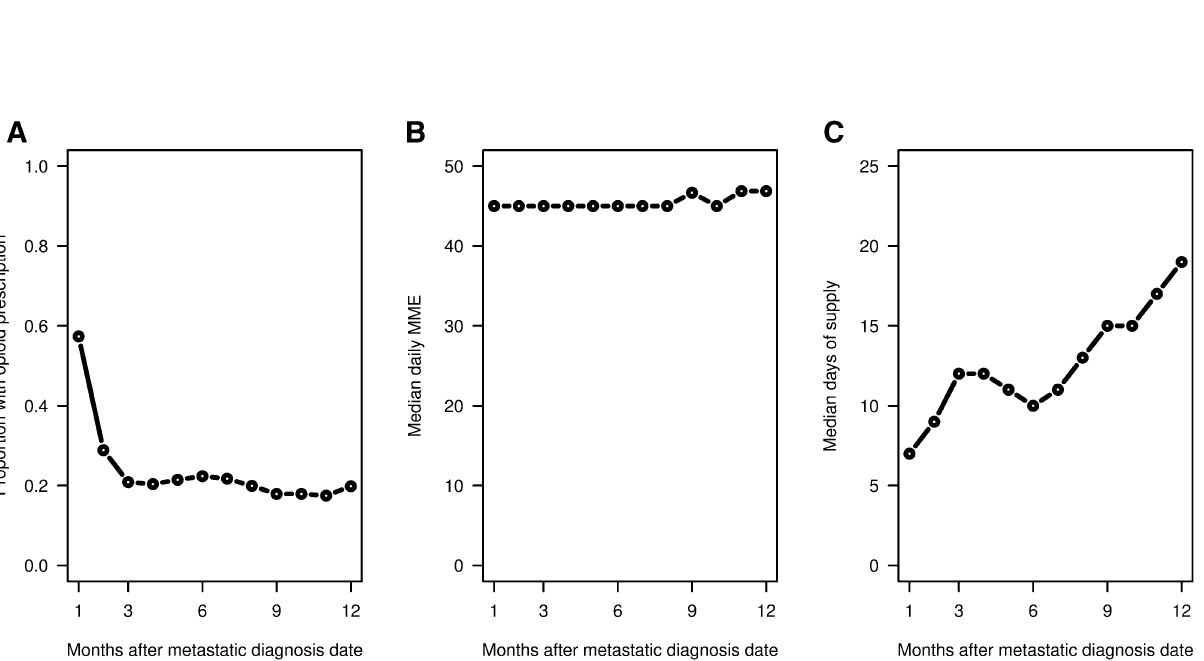
Figure 4. (Left) Proportion of patients with a prescription for an opioid by month after the metastatic diagnosis date. (Middle) Median daily MMEs and (Right) Median days of supply for patients who had a prescription for an opioid within the month. Using R software (https ://www.R-proje